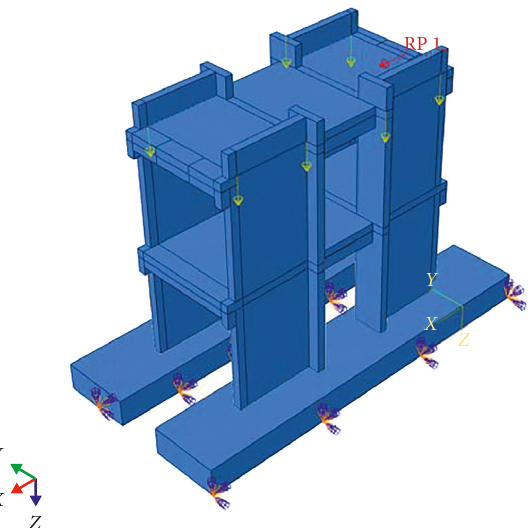
Figure 9: Loading simulation and boundary